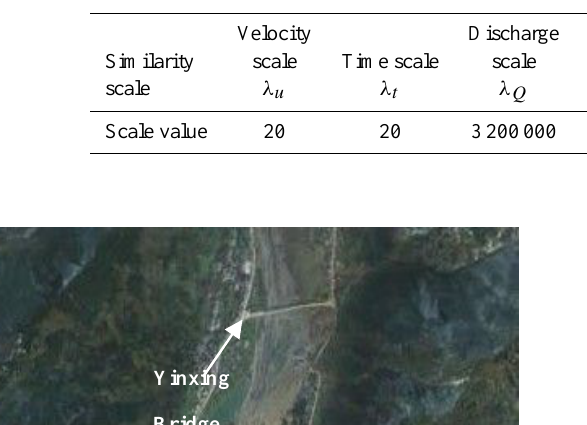
Table 3. Similarity scales of the model.